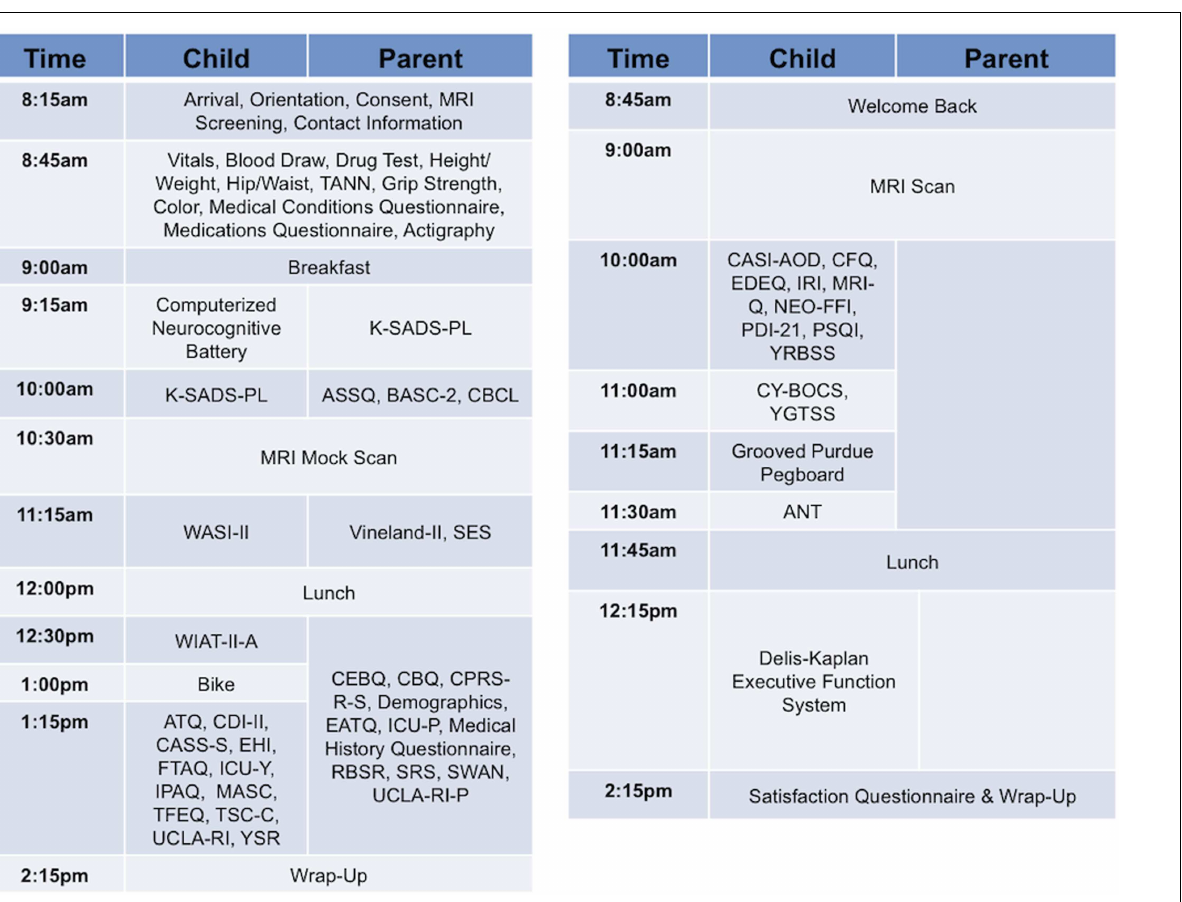
FIGURE 3 | Sample schedule for child and parent participants in NKI-RS. This figure illustrates the 2-day assessment schedule for child and parent participants (children ages 6–17years) in the Nathan Kline Institute-Rockland Sample (NKI-RS) protocol. Abbreviations for the assessments: ANT,